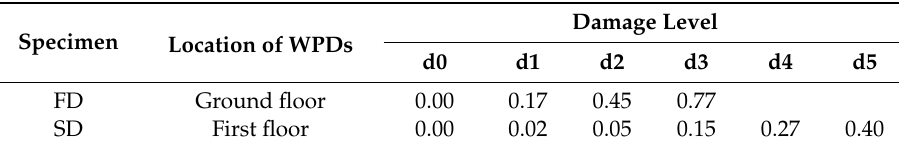
Table 1. Values of index ID i at different levels of damage to the WPDs.